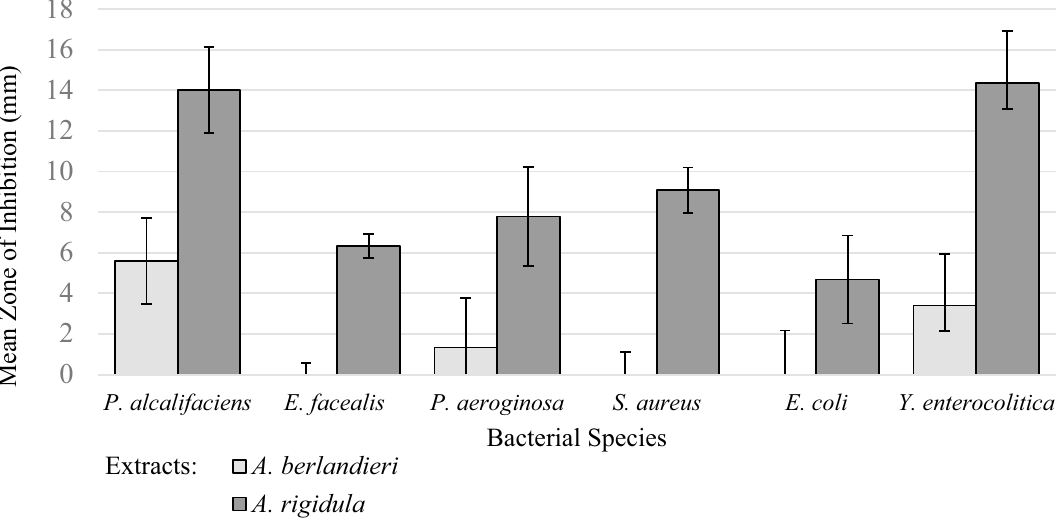
Fig. 1 Comparison of the antibacterial activities of A. berlandieri and A. rigidula . Non-overlapping CIs for side-by-side bars indicate signifi- cant difference in mean